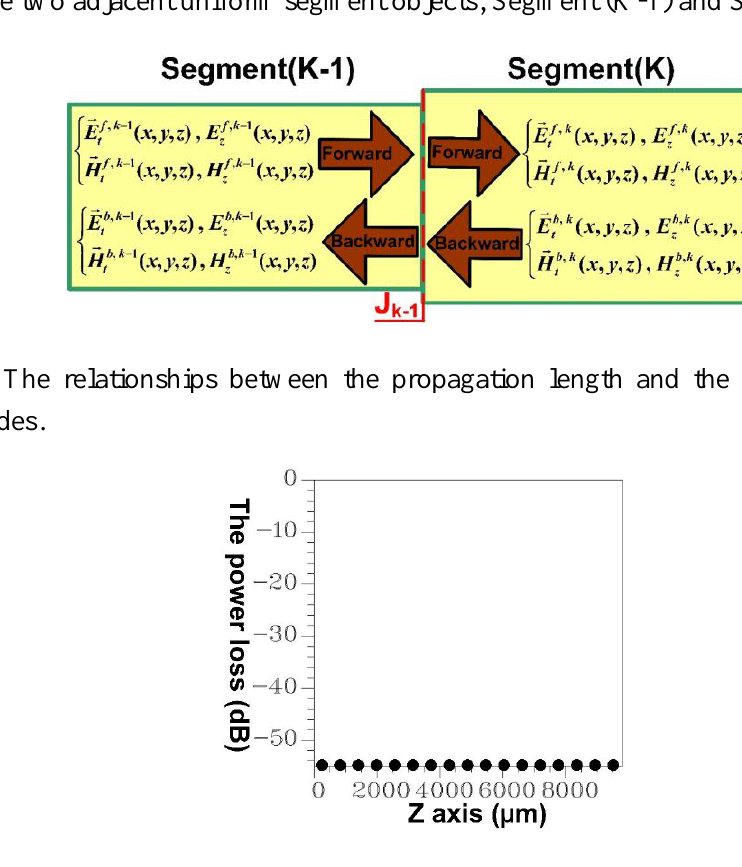
Figure 8. Fourier series expansion for the copropagation and counterpropagation modes between the two adjacent uniform segment objects, Segment (K-1) and Segment (K).